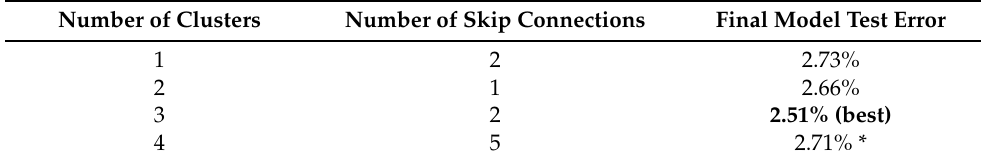
Table 3. Performance of the final model with respect to the number of clusters. Number of